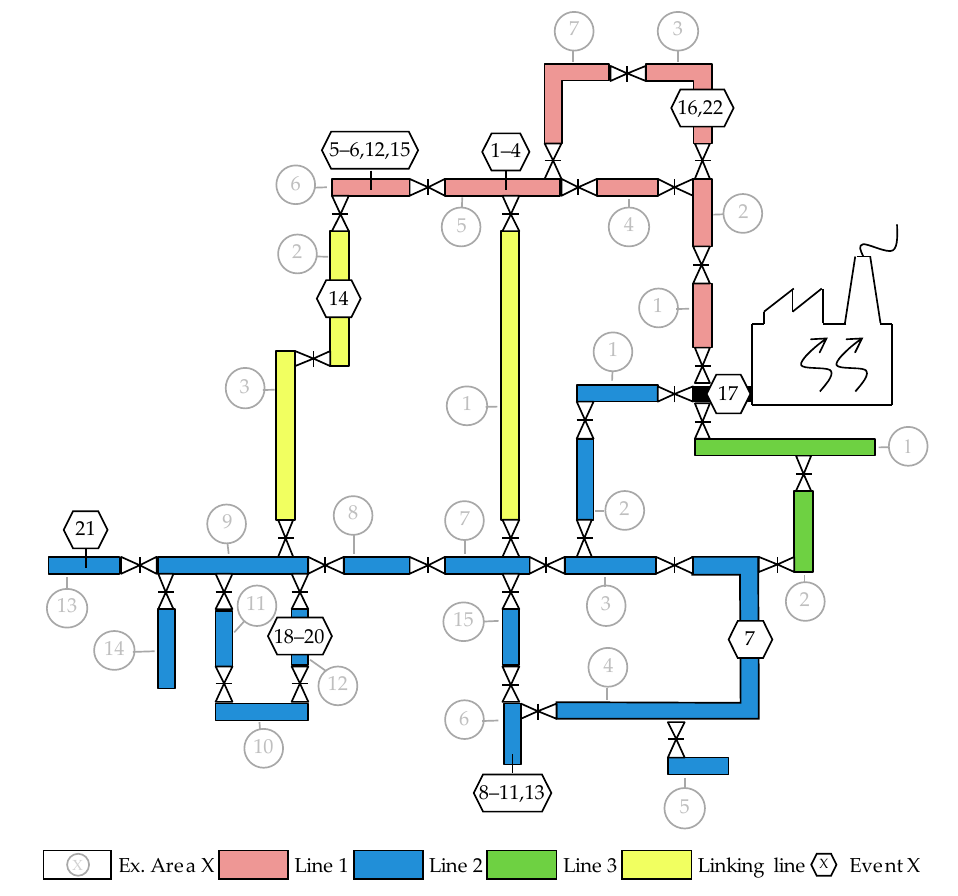
Figure 3. Representation of locations in the investigated network for each event. The figure shows that most of the real events are in the EAs line 2 No. 6, with five events. In addition, EA line 1 No. 5 and No. 6 contains four events each. Sometimes, it is the same refill process at one location which is divided into several events (e.g., events 1– 4). This is due to the valve opening, which is performed stepwise with waiting times in between. Each step causes a pressure wave which can be evaluated. The other events are distributed around the network. In Table 1, the 22 real events from Figure 1 are presented in detail, and they will be evaluated in the following. Table 1. Evaluation of 22 real events (Adapted with permission from Ref. [3]. 2022, Vahldiek).